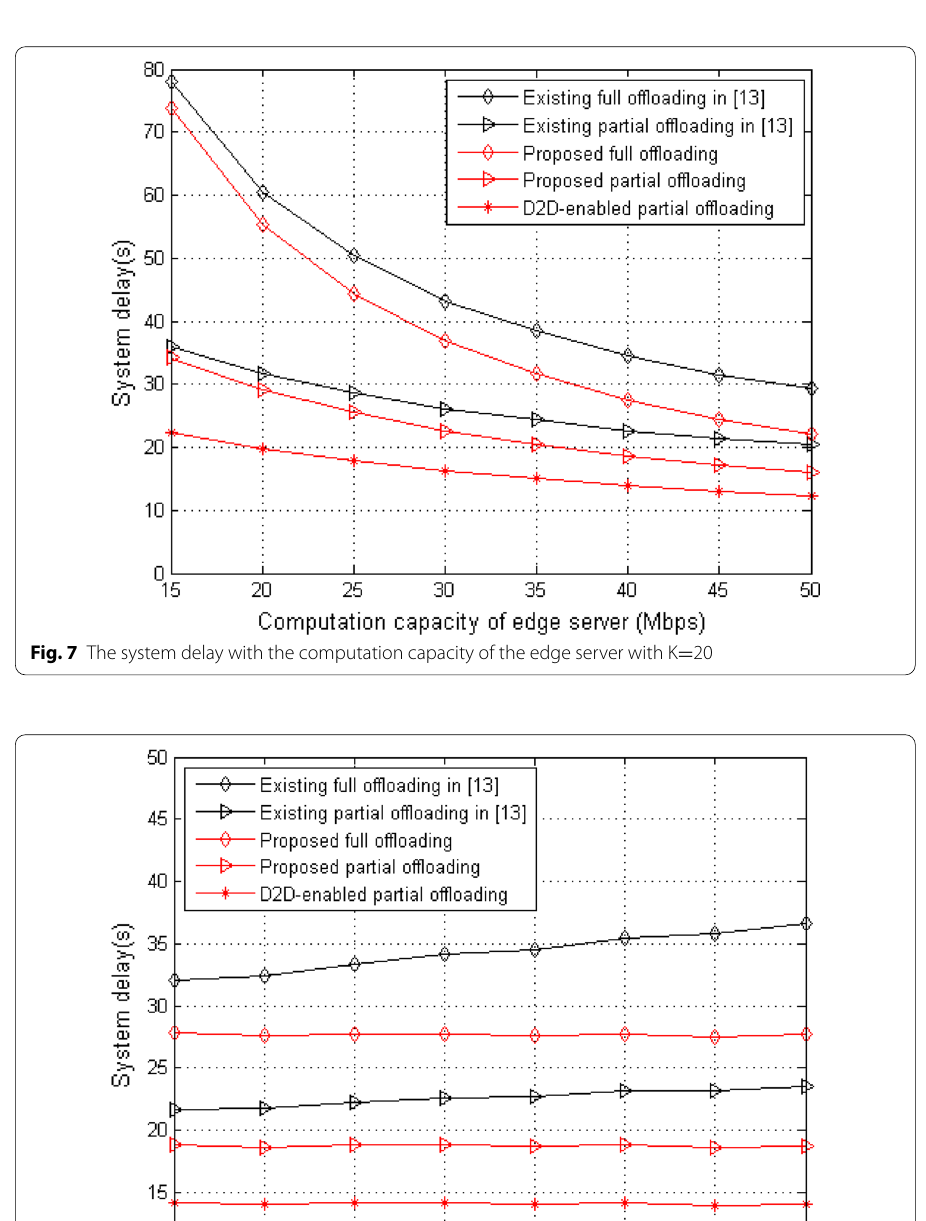
Fig. 8 The system delay versus the radius of